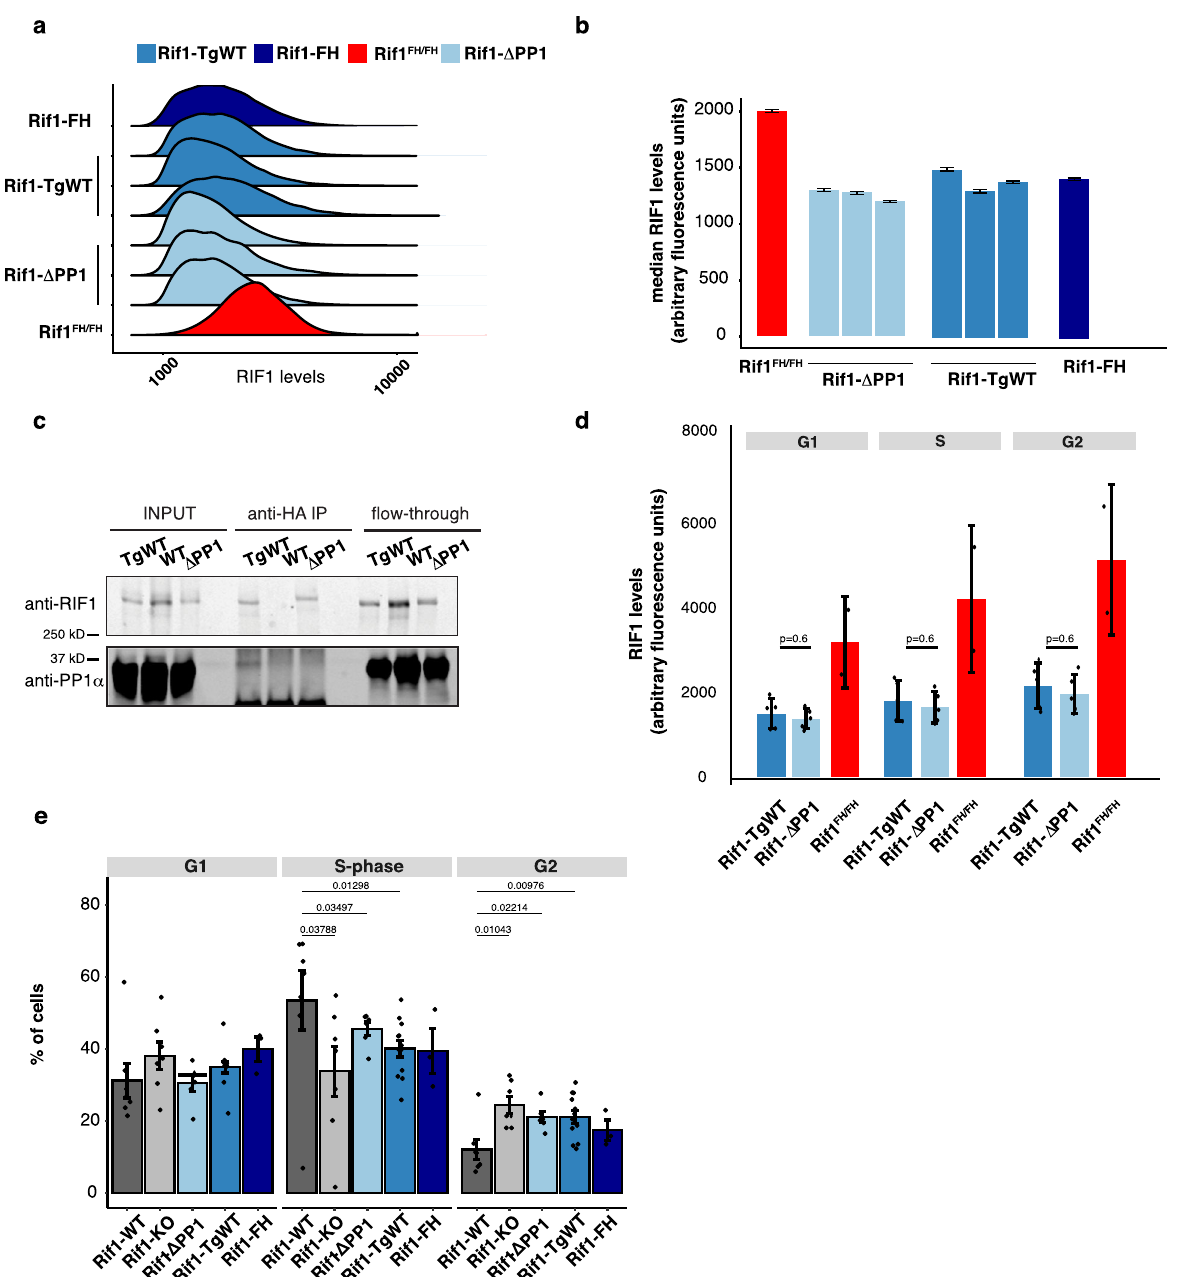
Fig. 1 Expression levels and chromatin association of RIF1-TgWT and RIF1- Δ PP1 are comparable to those of RIF1 in hemizygous cells. a Quantitative analysis of total levels of FH-tagged RIF1, measured by intra-cellular FACS staining. Anti-HA mouse ascites 16B12 was used to stain the indicated cell lines. Rif1 FH/FH : homozygous knock-in FH-tagged RIF1, as a control of quantitative staining. The plot shows distributions of densities from HA signal, measured in arbitrary units. One representative experiment is shown. b Quanti fi cation from Fig. 1a. The bar plot represents the median intensities for the experiment shown and the error bars indicate 95% con fi dence intervals, calculated through bootstrapping with 10,000 iterations. c Total proteins were extracted from cells expressing untagged wild type RIF1 (WT), or from hemizygote cells expressing RIF1-TgWT or RIF1- Δ PP1 (HA tagged), and immunoprecipitated with anti-HA antibody. The input, immunoprecipitated complex and fl ow through were analysed by western blot with anti-mouse RIF1 af fi nity-puri fi ed rabbit polyclonal antibody (1240) and anti-PP1 α . d Quantitative analysis of the levels of chromatin-associated FH-tagged RIF1 throughout the cell cycle measured by FACS staining. Cytoplasmic and nucleoplasmic proteins were pre-extracted before fi xing chromatin-associated proteins. Anti-HA mouse ascites 16B12 was used to visualise FH-tagged RIF1 as in a . Cell cycle stage was determined by DNA quanti fi cation (DAPI staining). Means from the results from two independent experiments, each with 2 or 3 independent cell lines per genotype are summarised. The error bars indicate standard deviations. P values were calculated by two-sided unpaired t test. e Cell cycle distribution of the indicated cell lines, as determined by FACS quanti fi cation of EdU incorporation (S- phase) and DAPI staining (DNA amount). The mean value of three independent clones per genotype, from three experiments is shown. Error bars indicate the standard error of the mean. P values are calculated using two-sided Wilcoxon rank-sum test.